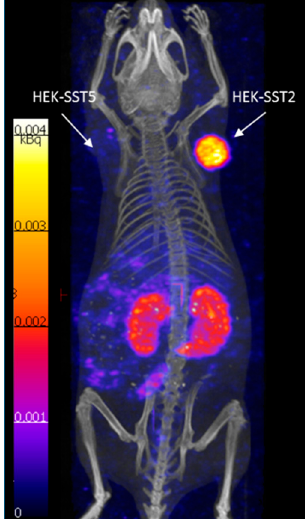
Figure 5. Maximum intensity projection (MIP) SPECT/CT images of [ 177 Lu]Lu-DOTA-ST8950 in a dual SST2- and SST5-expressing tumor mouse model, 4 h after injection.